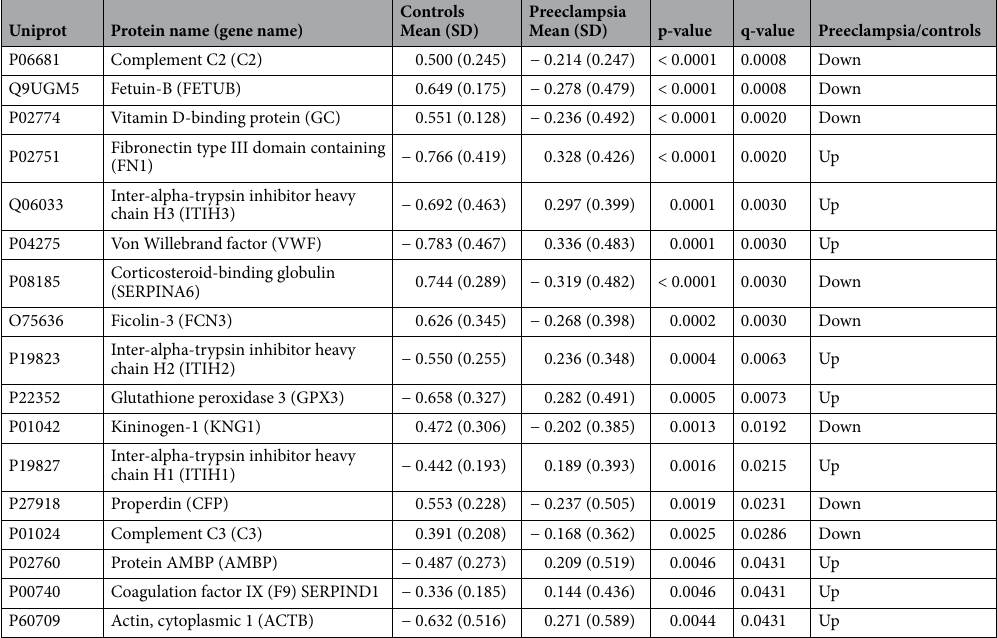
Table 2. Univariate analysis results, 17 proteins were significantly different in preeclampsia vs controls after false discovery rate correction (q-value <